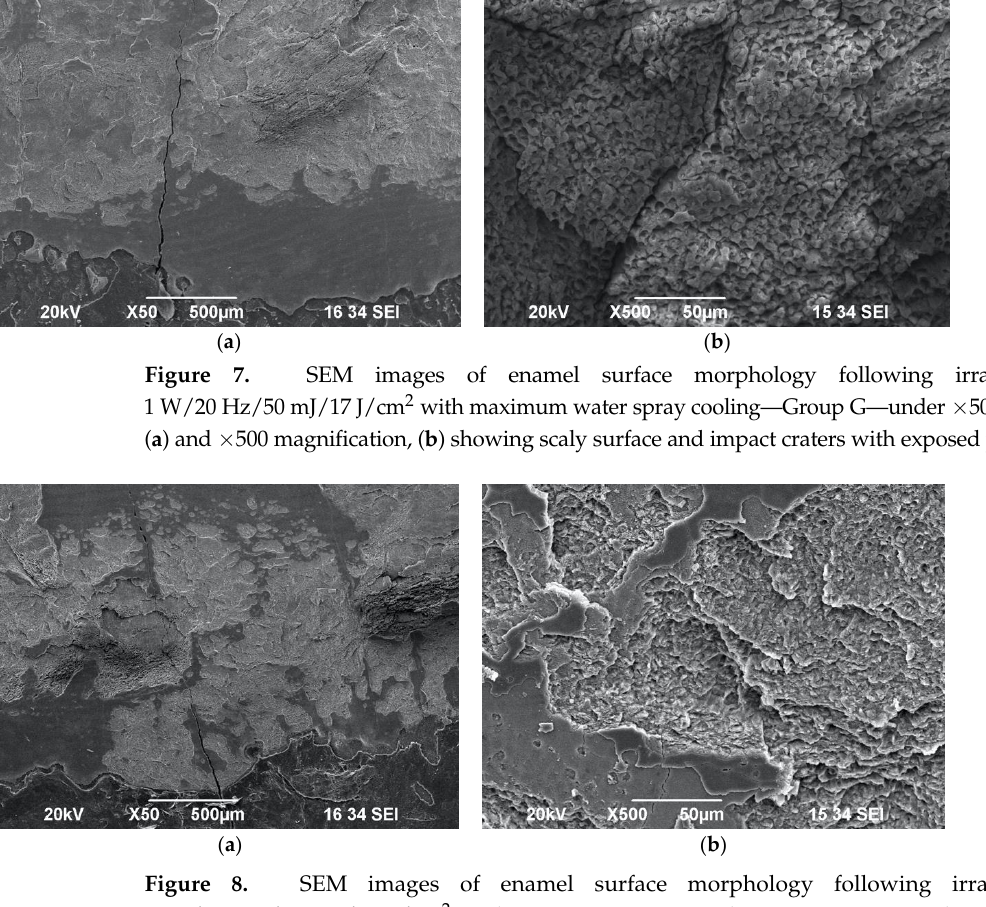
Figure 6. SEM images of enamel surface morphology following irradiation with 0.75 W/15 Hz/50 mJ/12 J/cm 2 without water spray—Group F—under ×50 magnification ( a ) and ×500 magnification ( b ), showing scaly surface and wide-diameter impact craters.